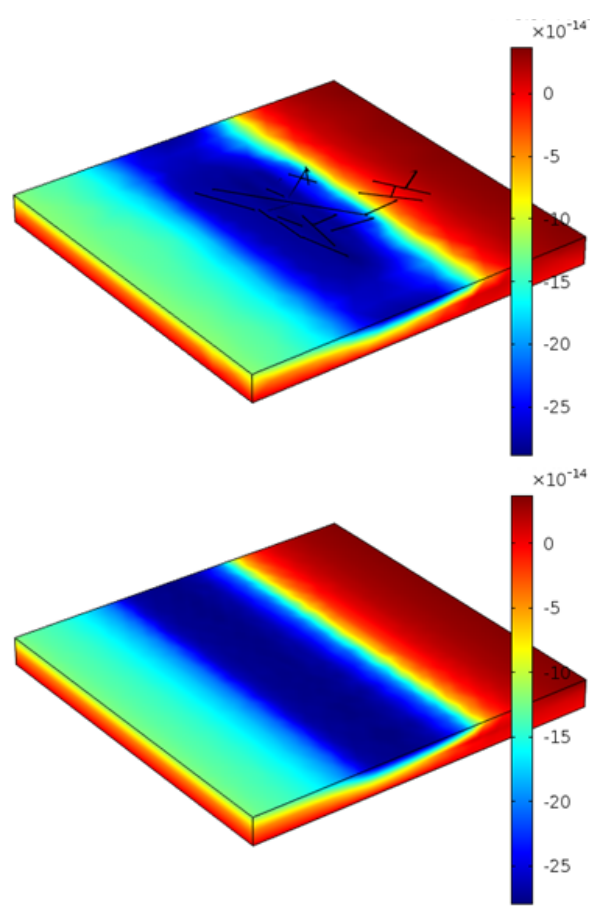
Figure 4. Vertical fluid velocity [ms − 1 ] in the homogeneous rock for the fracture-biased mesh with 158728 elements (top) and for the regular mesh with 5786 elements (bottom). Time is 5900 years and glacier velocity is 1.27myear − 1